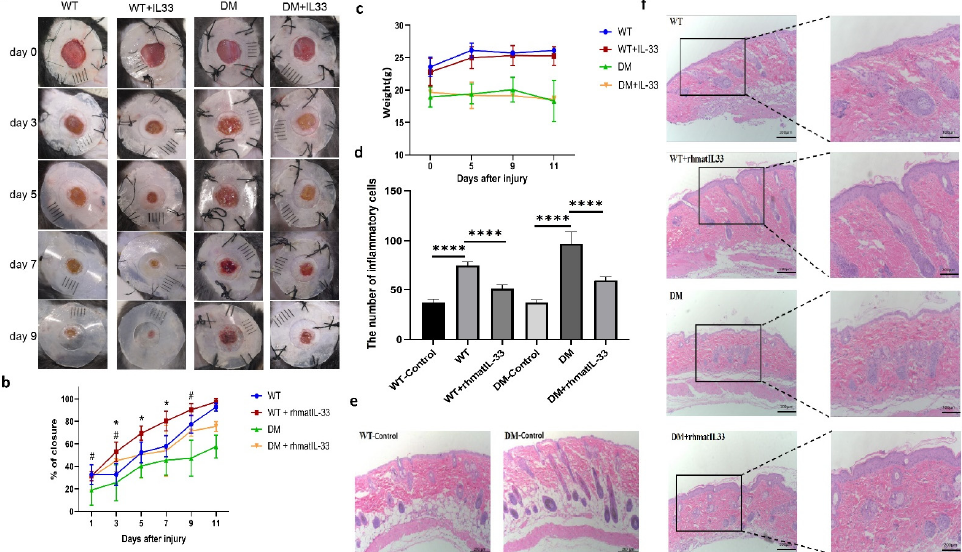
Figure 3. Effect of rhmatIL-33 on skin wound healing in mice. ( a ) Representative images of wounds at days 0, 3, 5, 7, and 9 post-administration. ( b ) The rate of wound closure in wounds receiving a different dose of rhmatIL-33 at the indicated times; # p , 0.05, for DM vs. DM + rhmatIL-33 group; * p , 0.05, for WT vs. WT + rhmatIL-33 group. ( c ) The body weight of mice receiving administration at the indicated times. ( d ) The number of inflammatory cells in the skin of mice; **** p , 0.0001. ( e ) HE staining of intact mouse skin. ( f ) H&E staining of wound sections treated with rhmatIL-33, PBS at day 5 post-administration (100×, 200×).